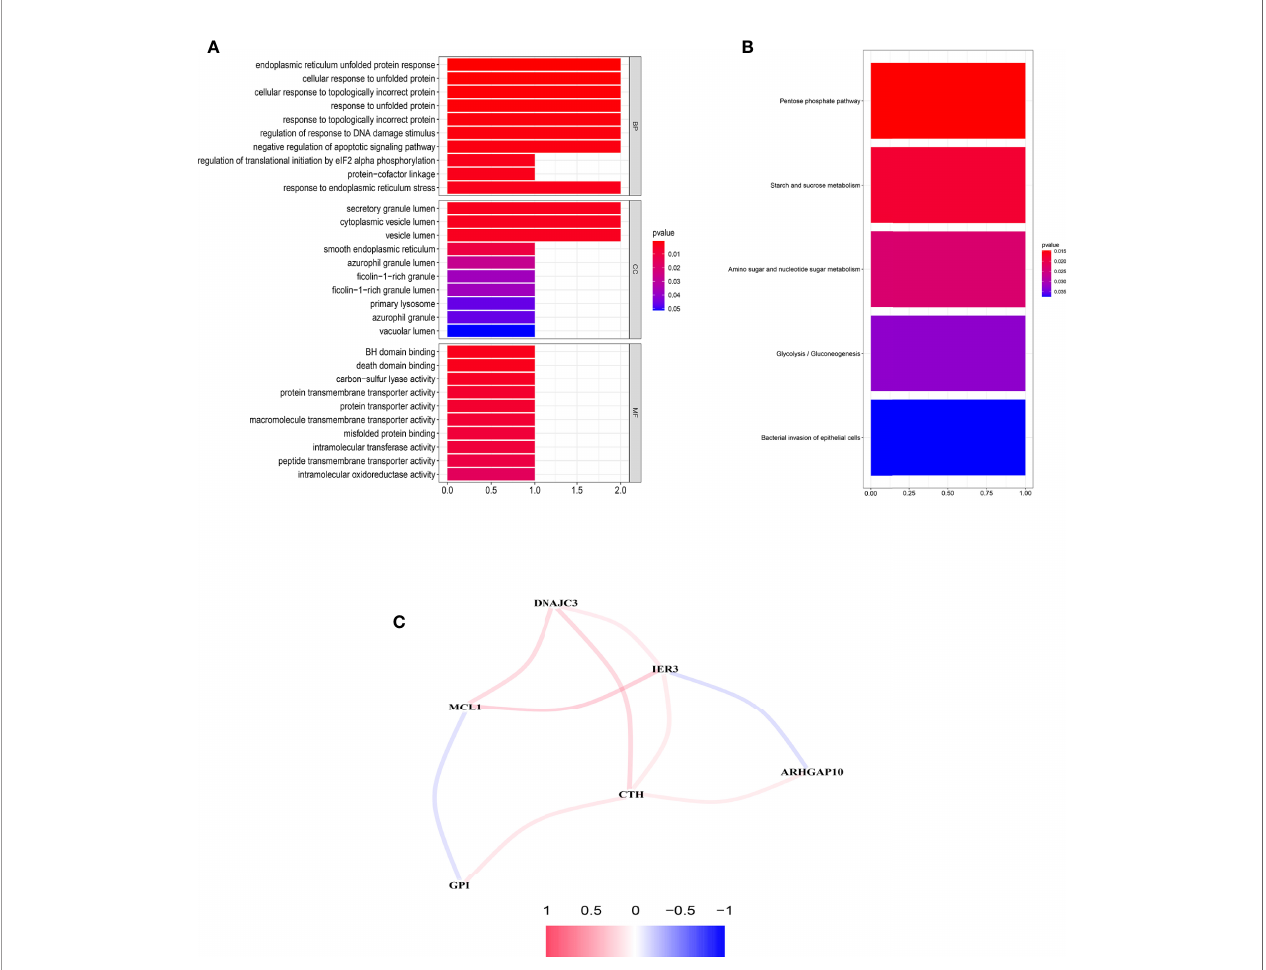
FIGURE 8 | Functional enrichment analysis and the construction of network. (A) GO analysis of the six prognostic ARGs. (B) KEGG analysis of the six prognostic ARGs. (C) Correlation network of the six prognostic ARGs. Red means a positive interaction, and blue indicates a negative